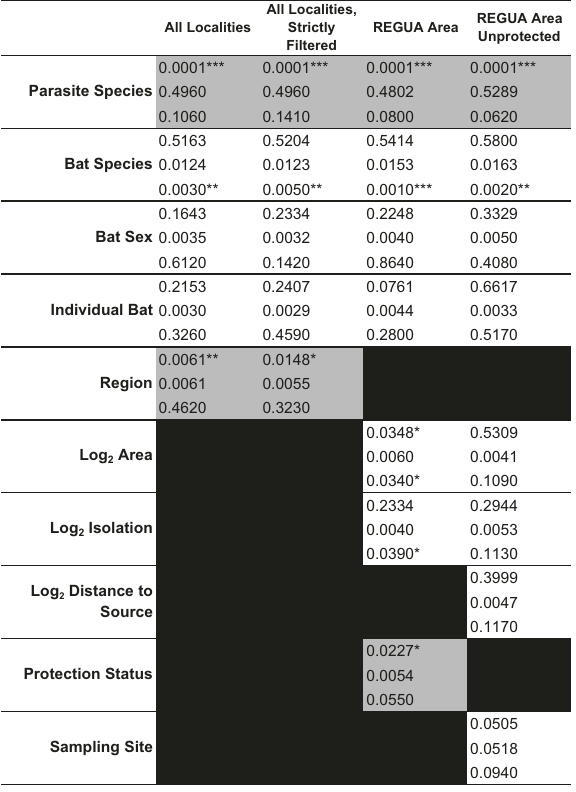
Table 3. Sequential Sum-of-Squares where the impact of each variable is considered after the impact of parasite species is